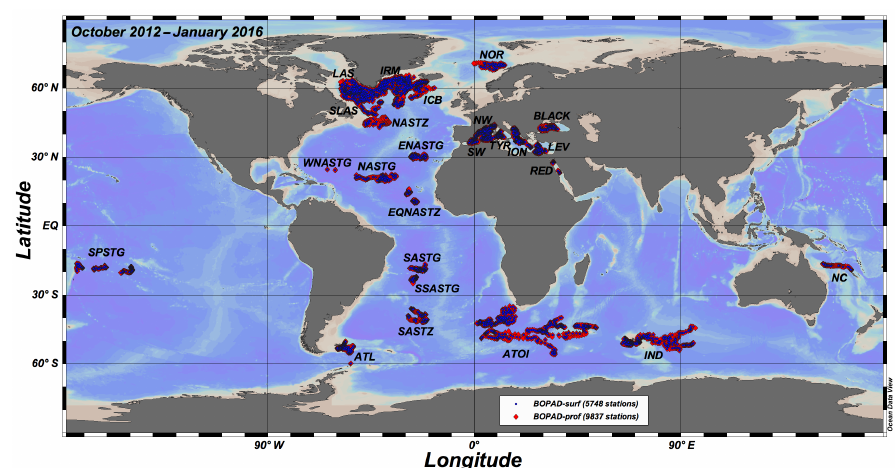
Figure 1. Red diamonds indicate the 9837 stations collected by 105 Biogeochemical-Argo floats in the period of October 2012–January 2016 that compose the database of vertical profiles (BOPAD-prof). Blue dots indicate the 5748 stations used to assemble the database within the first optical depth and devoted to bio-optical applications (BOPAD-surf). Abbreviations for the 25 geographic regions used to group the stations are also displayed (see Appendix A for full description). The map was drawn using the Ocean Data View software (R. Schlitzer, Ocean Data View,